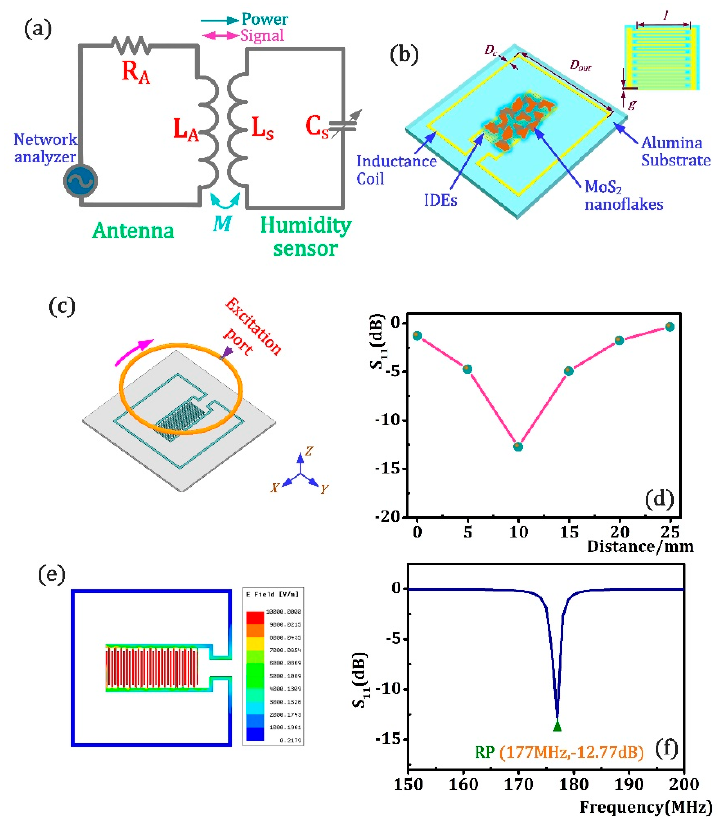
Figure 1. ( a ) Illustrative model schematic of LC wireless measurement; ( b ) as-designed humidity sensor; ( c ) the HFSS simulation model of as-designed humidity sensor; ( d ) the distance-S 11 curve of humidity sensor;(e) electric field distribution of sensor at 10 mm; ( f ) S 11 versus frequency curve of as-designed humidity sensor based on HFSS simulation at 10 mm; cc.